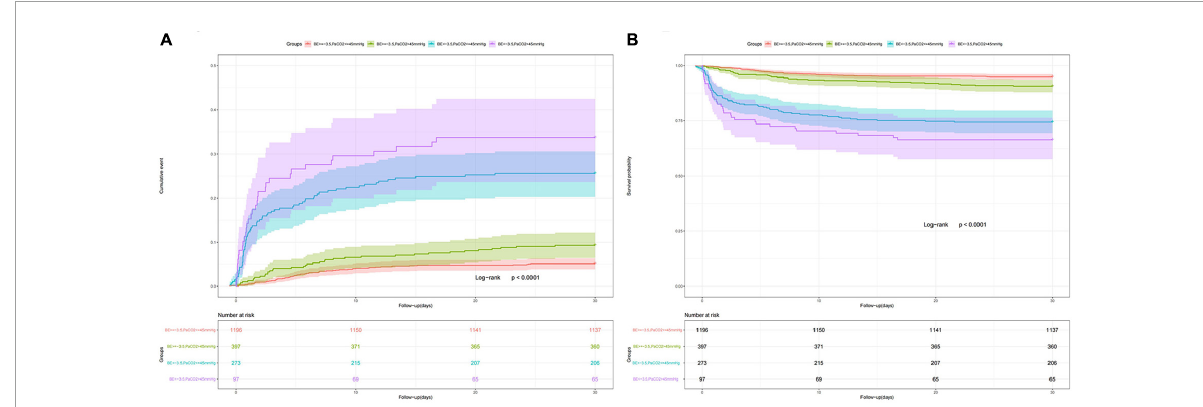
FIGURE4 Cumulative incidence (A) and Kaplan-Meier curve (B) of 28-day all-cause mortality stratified by BE and PaCO 2 . BE cutoff values (–3.5 mEq/L) were determined by receiver operating characteristic (ROC) analysis for 28-day all-cause mortality using the Youden